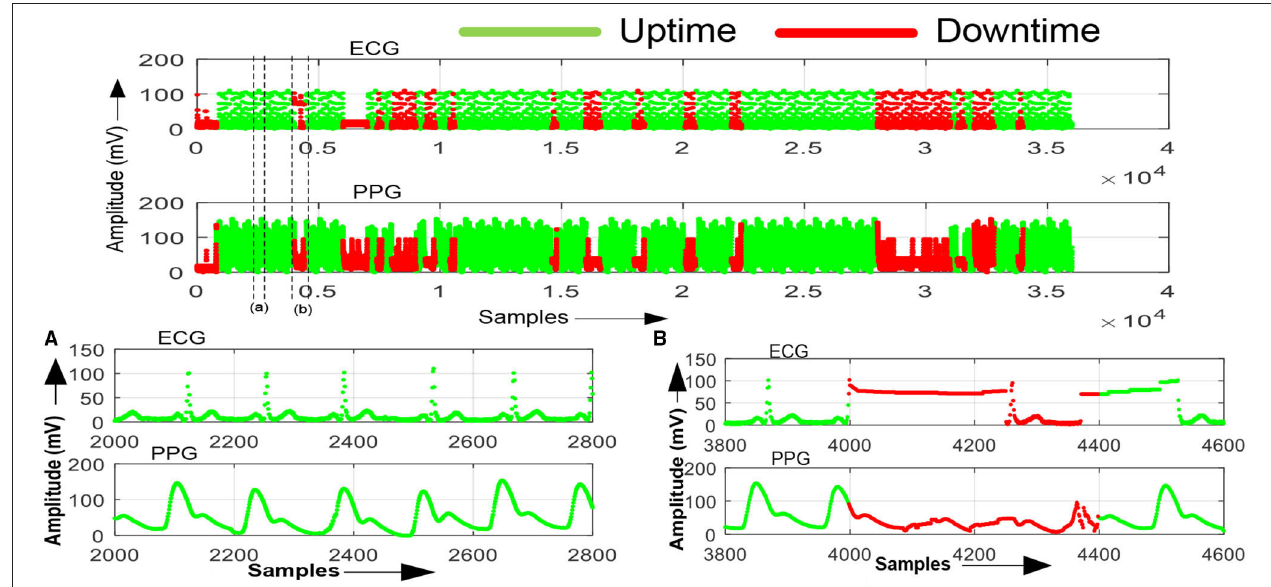
FIGURE 9 | ECG and PPG processed signals data captured using MATLAB tool w.r.t 2oo2 configuration. (A) System uptime—normal signal data with no-fault (green). (B) System downtime—abnormal signal data with a fault (red).